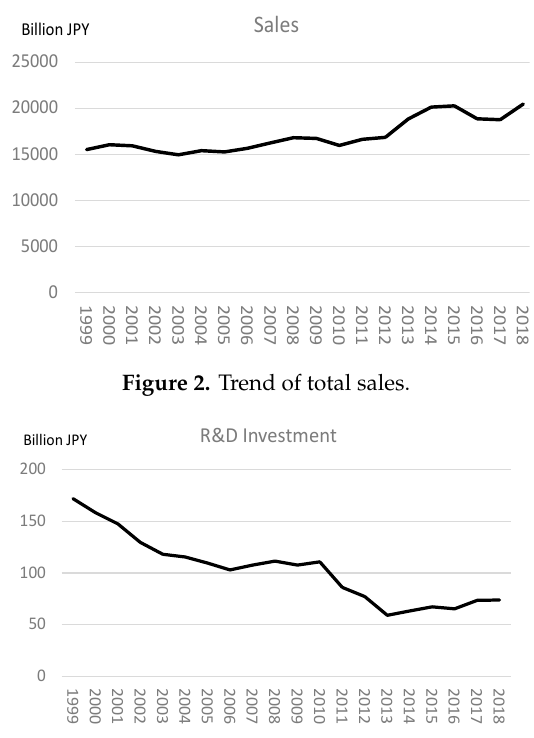
Figure 3. Trend of Research and Development (R&D) investment.